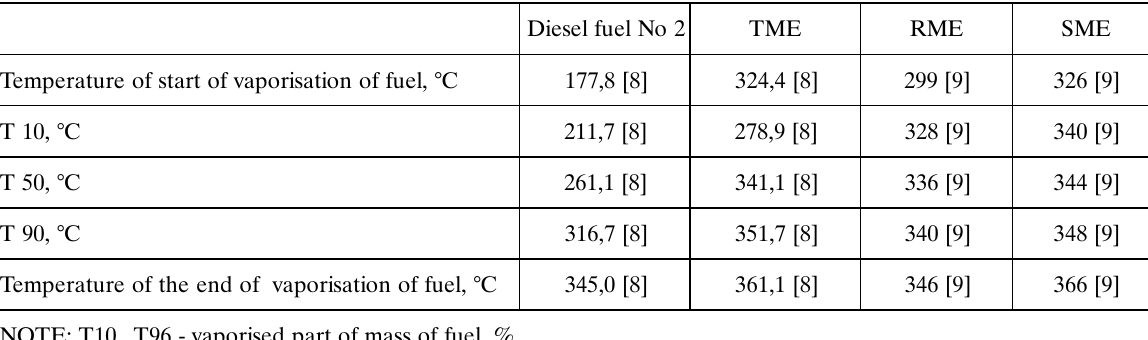
Table 2. Ranges of vaporisation of fuel